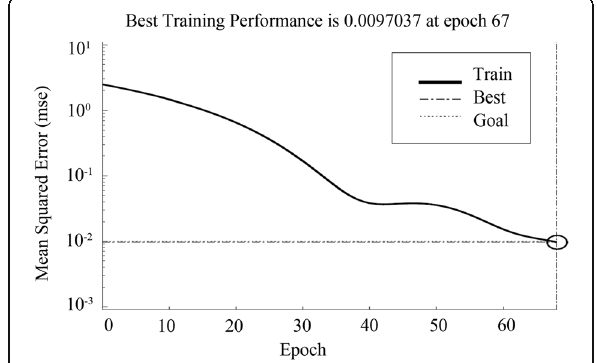
Fig. 15 Training curve of